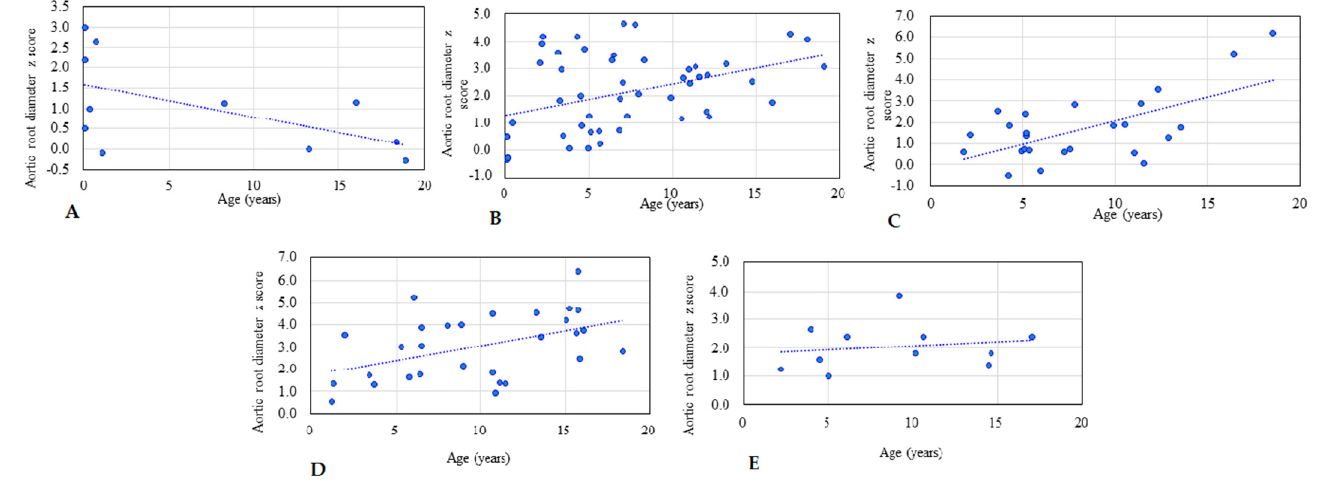
Figure 3. The relationships between aortic root diameter z score and age for each type of MPS. ( A ) MPS I ( n = 11, r = − 0.566, p < 0.05); ( B ) MPS II ( n = 49, r = 0.394, p < 0.01); ( C ) MPS III ( n = 25, r = 0.624, p < 0.01); ( D ) MPS IV ( n = 29, r = 0.457, p < 0.01); ( E ) MPS VI ( n = 11, r = 0.161, p > 0.05). The dotted line represents the trendline. Table 2. Demographic characteristics and aortic root diameter measurements in patients with the mild form and severe form of MPS II ( n =